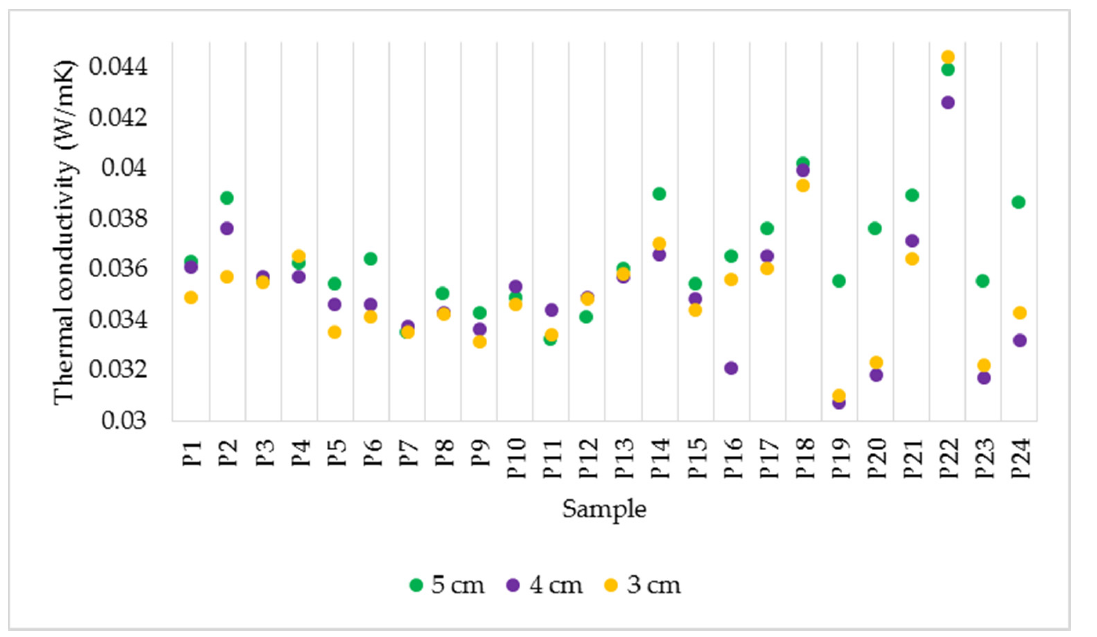
Figure 7. Variation of thermal conductivity for the samples with thicknesses of 5, 4 and 3 cm. Analysing the case of thermal resistance in Figure 8, a significant influence of the thickness of the specimen is noticed. As the thermal resistance is directly proportional to thickness, the maximum values were recorded for the thickest specimens. It was observed that in the case of specimens with a thickness of 3 cm, the variation of the thermal resistance value is almost linear for the samples obtained by spraying.